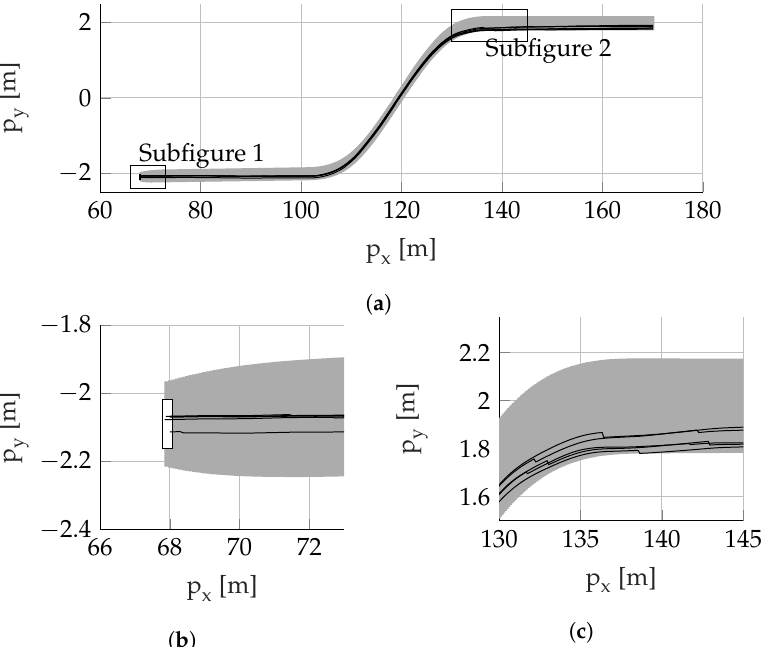
Figure 6. Projection of the measurements (black lines) and the reachsets of the model (gray area) to the position for the single lane-change maneuver. ( a ) Overview. ( b ) Subfigure 1: Zoom on the initial set (white box). ( c ) Subfigure 2: Zoom on the point in time, where the measured data comes closest to the reachset